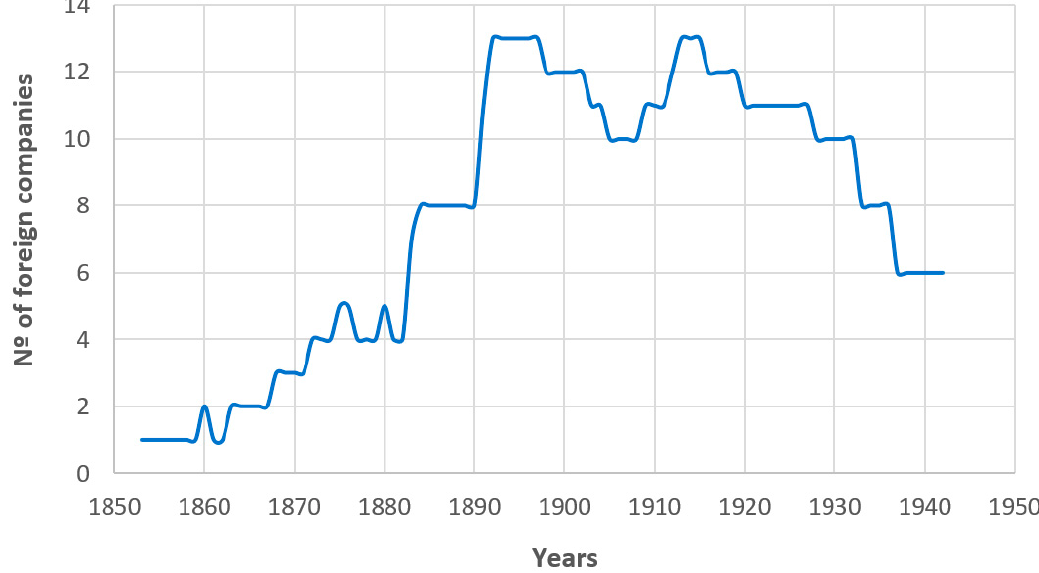
Figure 7. Evolution of the number of foreign companies from 1853 to 1942.